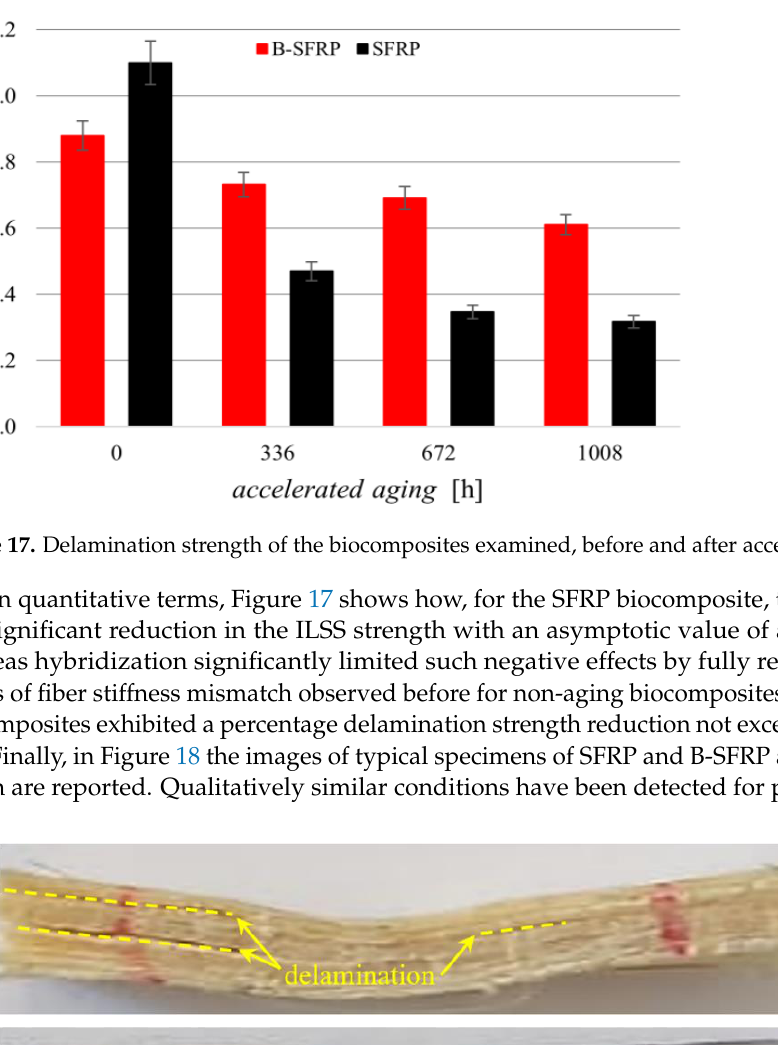
Figure 16. Specific shear curves obtained by the ILSS test for both the biocomposites examined.